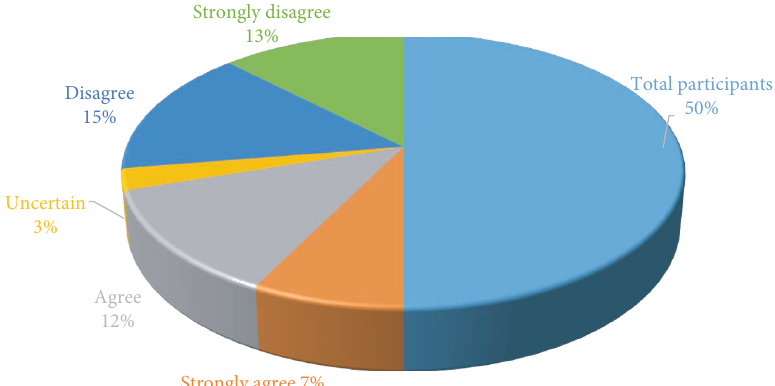
Figure 19: Acceptability of use.